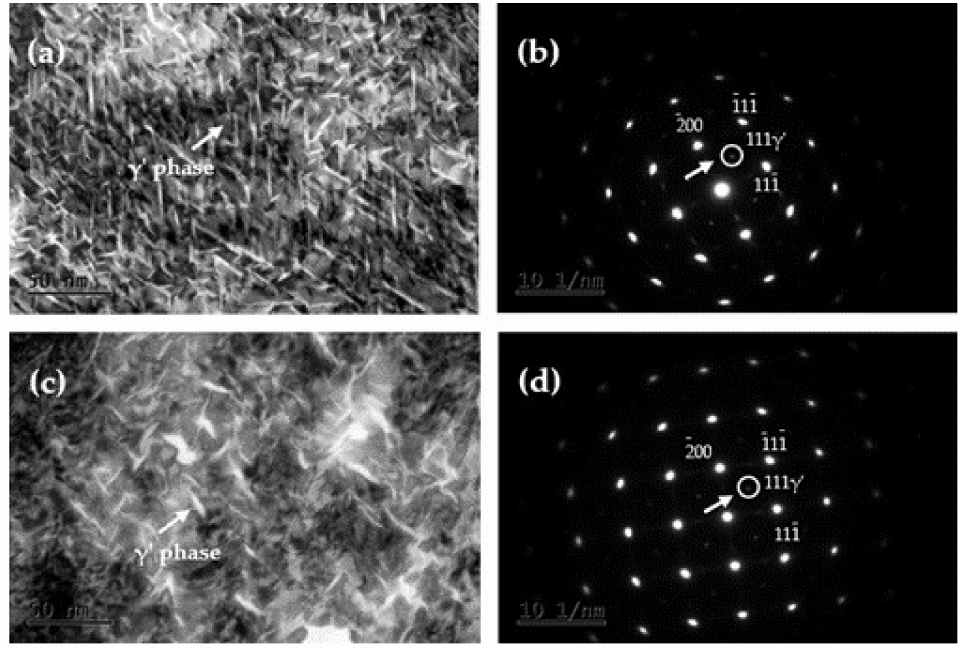
Figure 5. TEM images of alloys at the peak aging. ( a ) Bright field TEM image of C17200; ( b ) SAED corresponding to ( a , c ) bright field TEM image of QBe2.0; ( d ) SAED corresponding to ( c